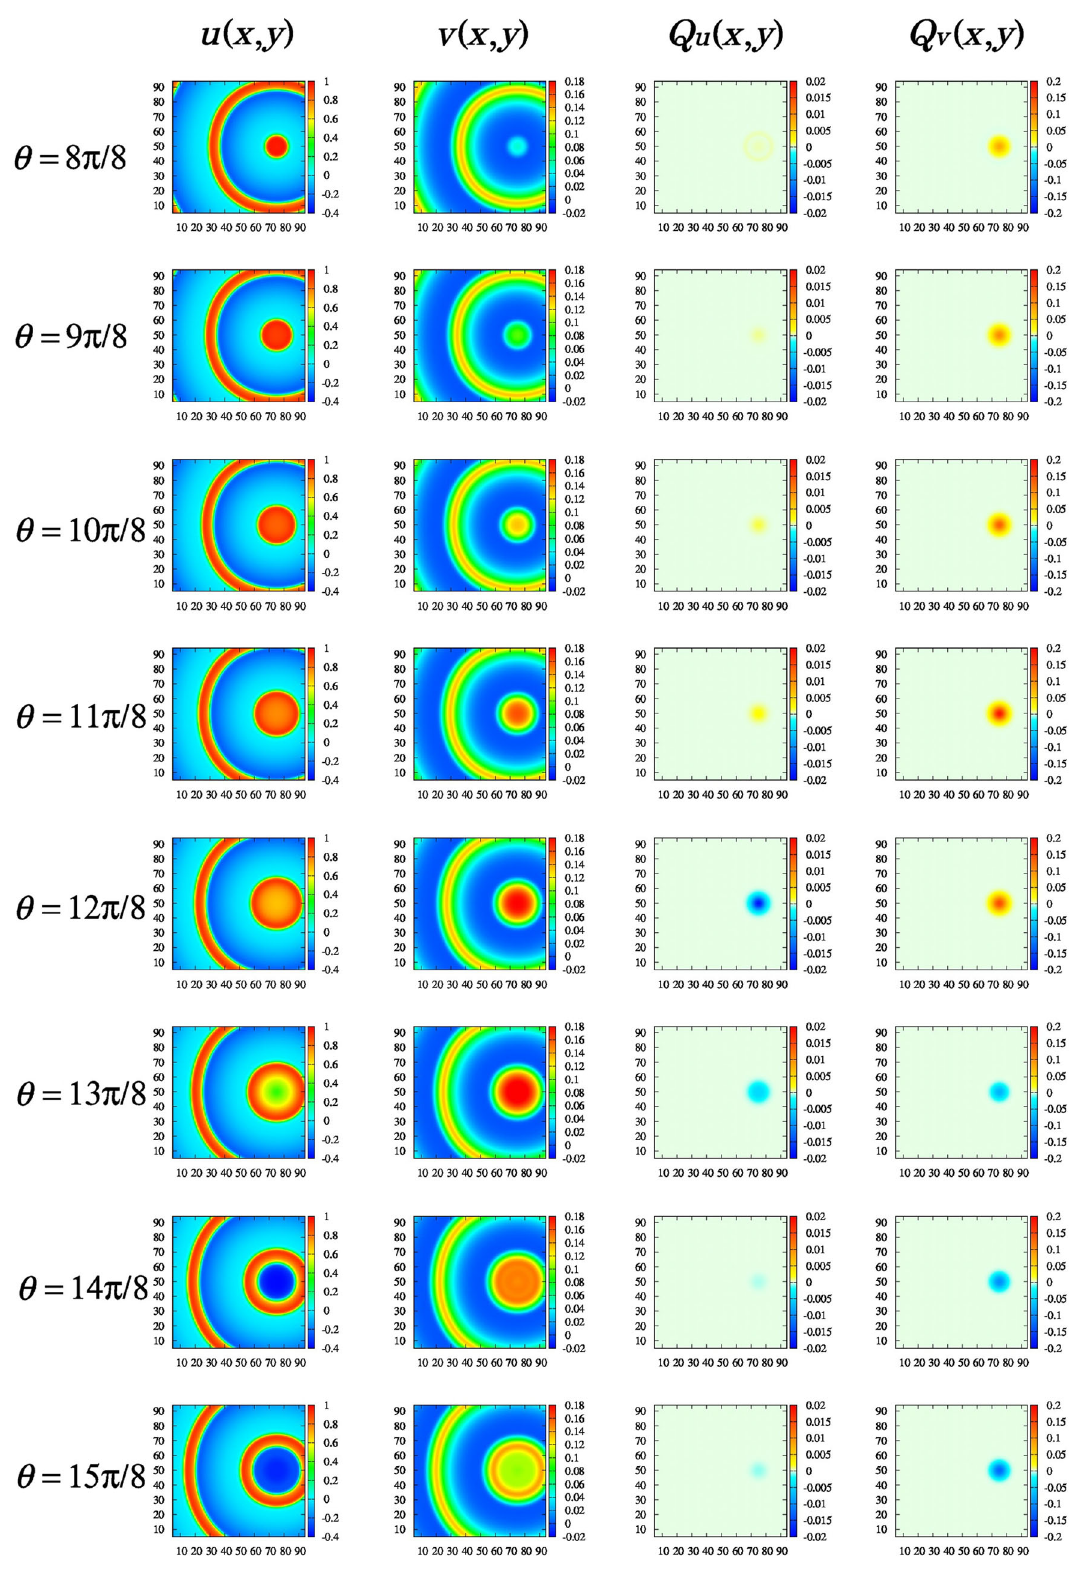
FIG. 8. Limit-cycle solution X 0 ð r ; θ Þ and phase-sensitivity function Q ð r ; θ Þ of the target wave for θ ¼ 8 π = 8 ; 9 π = 8 ; 10 π = 8 ; … ; 15 π = 8 . First column: Activator ( u ) component of X 0 ð r ; θ Þ . Second column: Inhibitor ( v ) component of X 0 ð r ; θ Þ . Third column: u component of Q ð r ; θ Þ . Fourth column: v component of Q ð r ; θ Þ . The parameters are the same as in Fig.